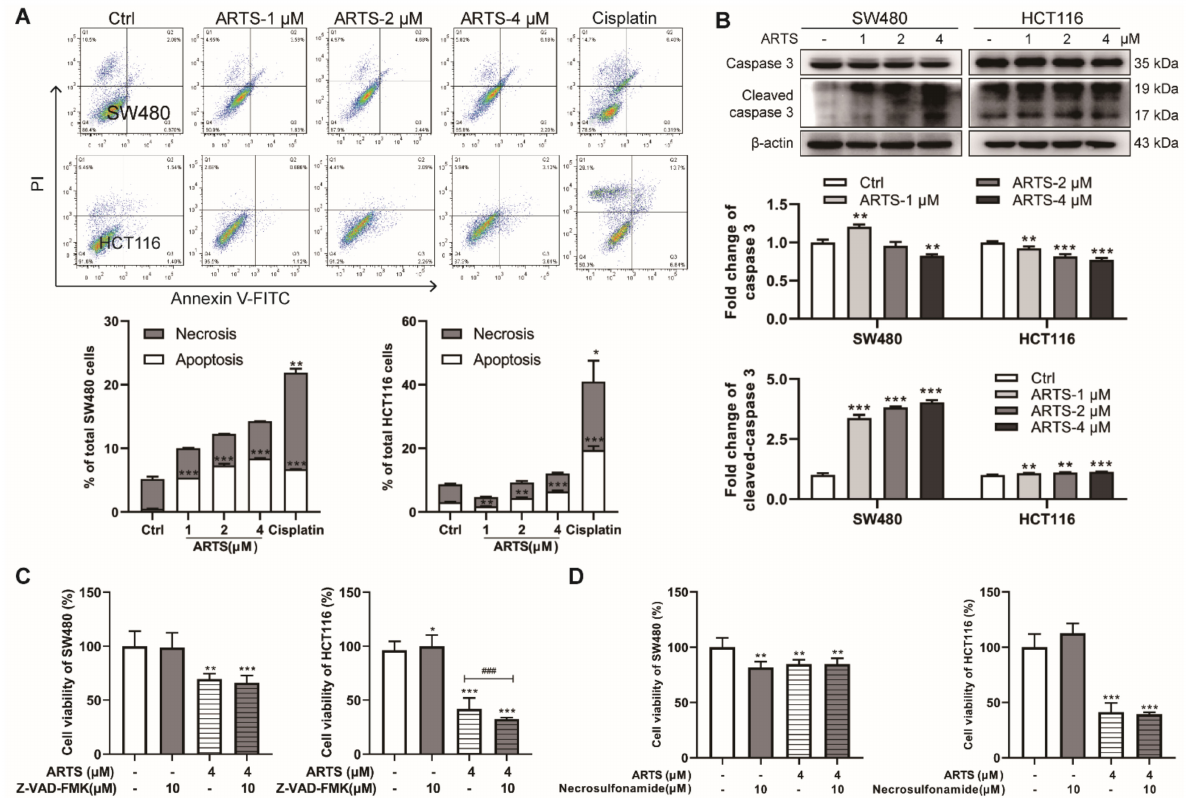
Figure 2. Artesunate-induced mild apoptosis could not help to inhibit cell viabilities of SW480 and HCT116. ( A ) Artesunate only induced mild apoptosis in SW480 and HCT116. Cells were seeded in 6-well plates and treated with artesunate (1, 2, and 4 µ M) for 72 h. Afterwards, all cells (suspended and attached) were harvested. After incubation with anti-Annexin V-FITC primary antibody and PI solution, apoptotic cells were detected via flow cytometry. Cisplatin was used as positive drug for cell apoptosis at a concentration of 30 µ M for 24 h. ( B ) Artesunate upregulated the protein level of cleaved-caspase 3 in SW480 and HCT116. Cells were seeded in 60 mm dishes and treated with artesunate (1, 2, and 4 µ M) for 72 h. Then, cells were lysed with RIPA to extract total protein. The protein levels were measured by western blotting. The gray values of protein blots were evaluated by Image J. Relative protein expression was normalized to β -actin. ( C ) Z-VAD-FMK, a pan-caspase inhibitor, and ( D ) necrosulfonamide, a necrosis inhibitor, could not help to restore cell viabilities. Z-VAD-FMK and necrosulfonamide were used at a concentration of 10 µ M and added alone or together with artesunate (4 µ M) for 72 h. Cell viabilities were detected via CCK8 assay. * p < 0.05, ** p < 0.01, and *** p < 0.001 vs. Ctrl. ### p < 0.001 vs. cells treated with artesunate alone. Data were shown as mean ±